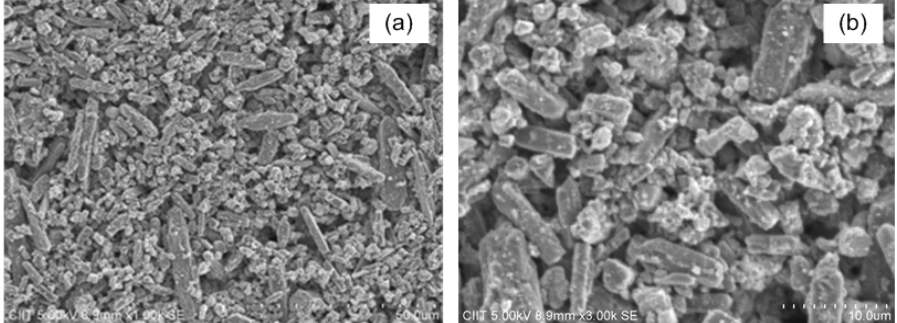
Figure 2. ( a ) and ( b ) represent SEM micrographs of Cu 3K magnification,